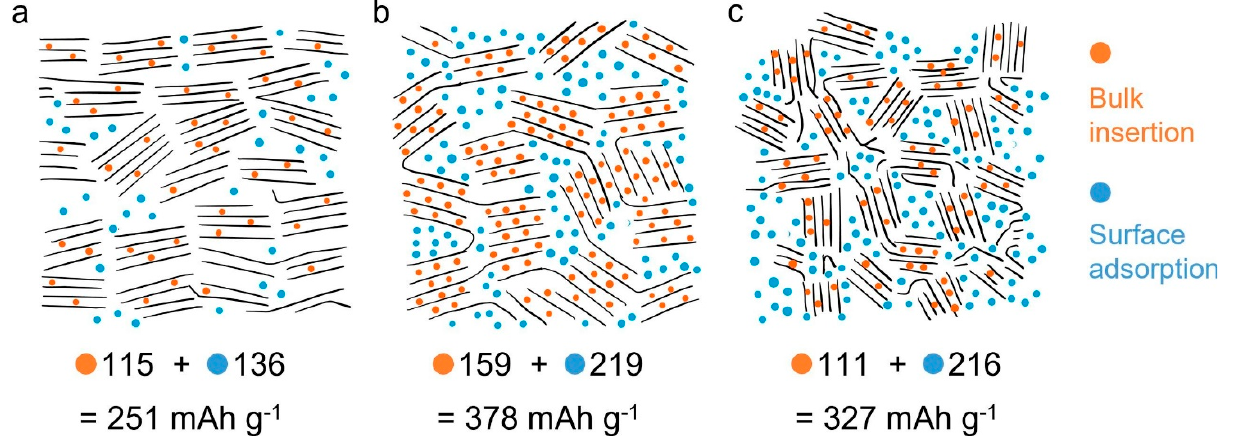
Figure 2. Proposed K-ion storage mechanisms in L700 ( a ), M700 ( b ), and H700 ( c ). Reprinted with permission from [53] Copyright 2022, Elsevier.